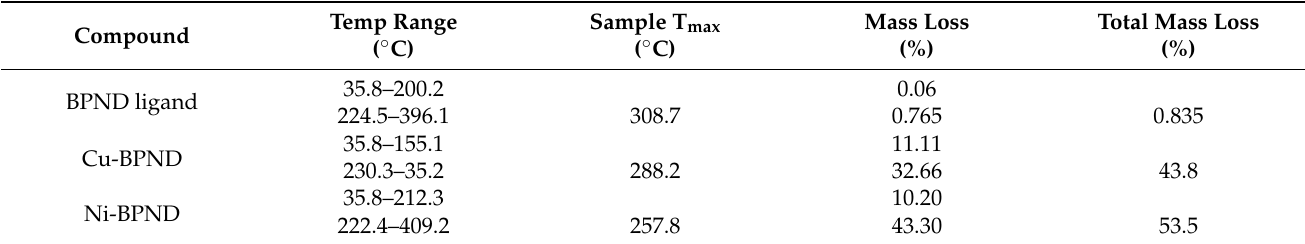
Figure 4. A thermogram for a Schiff base ligand only ( A ) and an overlay of thermograms for the Schiff base ligand, nickel(II), and copper(II) complexes ( B ) in the temperature range 35.8 °C to 700 °C under nitrogen gas. Table 1. Thermoanalytical data of the BPND ligand and its metal complexes.